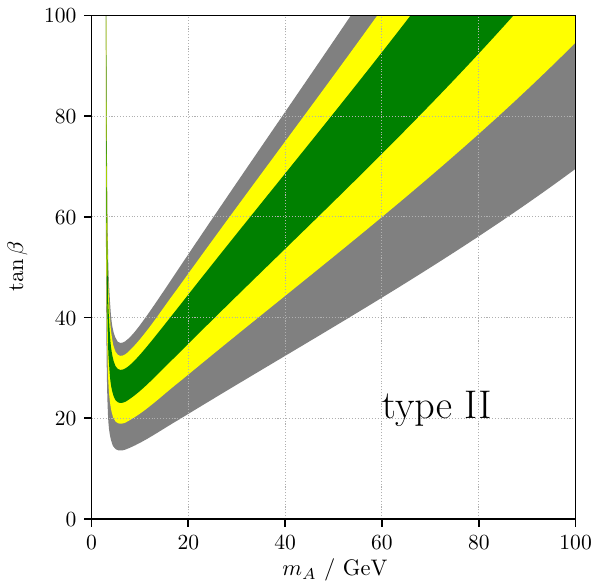
Fig. 1 Two-loop prediction of a BSM μ in the 2HDM of type II (left) and green, yellow and gray regions the 2HDM predicts the correct value of a BSM μ = ( 25 . 1 ± 5 . 9 ) × 10 − 10 from Eq. (3) within one, two and three type X (right) as a function of tan β and m A with m h = 126GeV, m H = m H ± = 200GeV, sin (β − α) = 1, λ 6 = λ 7 = 0, standard deviations, √ = m 2 / tan β + ( m 2 − λ v 2 )/ tan 3 β and λ = m 2 4 π . In the 1 1 H h 12